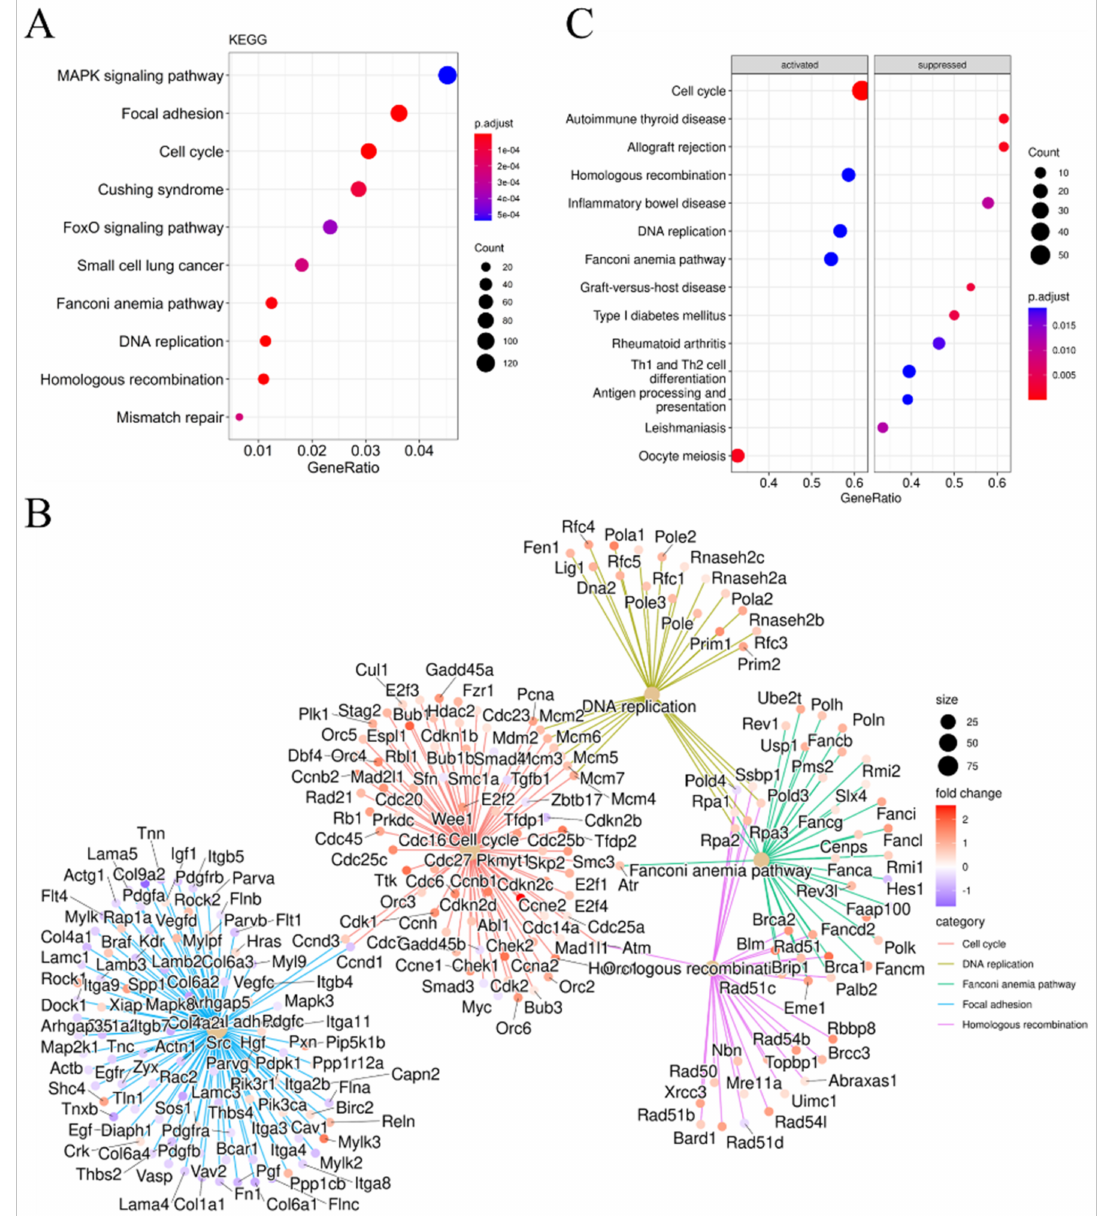
Figure 4. KEGG and GSEA analysis of DEmRNA in 14-month-old DKO mice spleen. ( A ) KEGG pathway analysis of mRNAs. Colored dots represent the fold change in gene expression in different pathways. The x -axis represents the gene ratio. The y -axis gives the enrichment analysis terms. ( B ) The net plot of KEGG pathways shows the enrichment of DEmRNAs in different pathways. Plot colors represent the p -values and sizes represent the gene numbers. ( C ) Gene set enrichment analysis (GSEA) for DEmRNAs. The x -axis represents the gene ratio. The y -axis gives the enrichment analysis terms. Plot colors represent the p -values and sizes represent the gene numbers. DEmRNAs: differentially expressed mRNAs; KEGG: Kyoto Encyclopedia of Genes and Genomes; GSEA: gene set enrichment